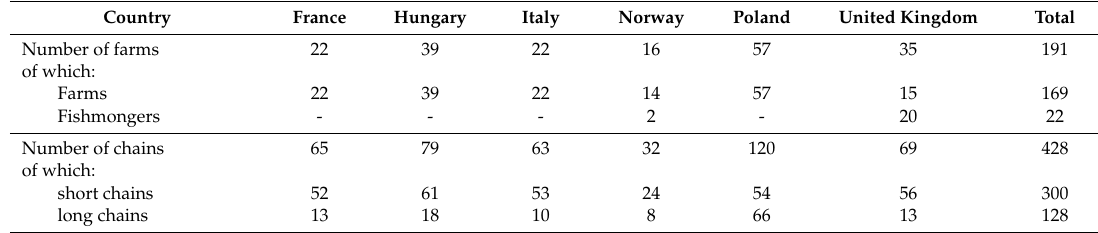
Table 1. Number of farms and chains in the research sample.